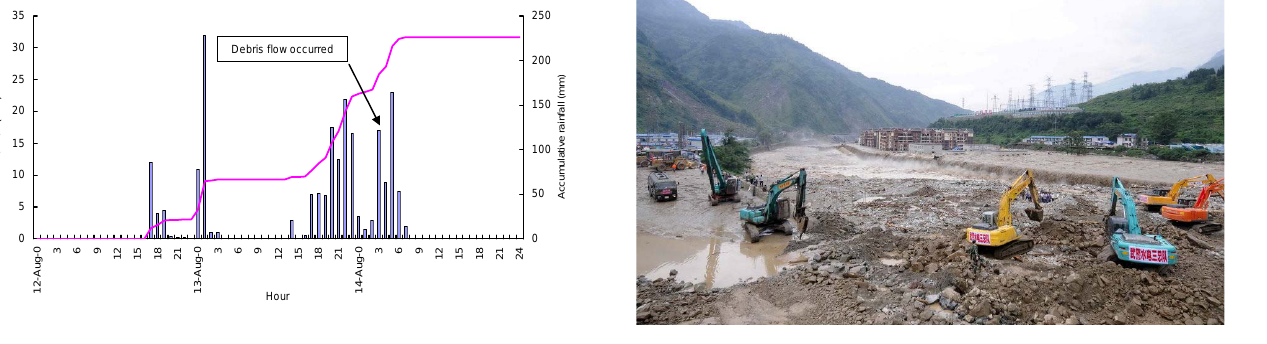
Fig. 14. Drainage works for the debris dam in Yingxiu Town after the 8.13 Hongchun gully debris flows.